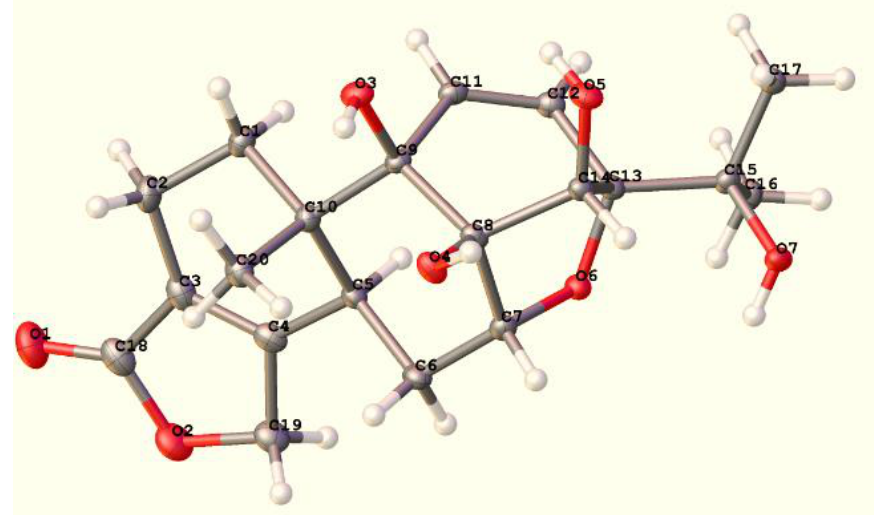
Figure 4. Single crystal structure of compound 1 .